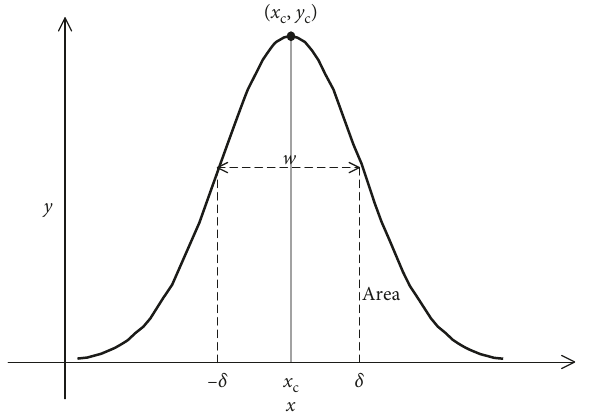
Figure 2: A Gaussian fitting curve of equation (8). Table 1: Details on EC stations used for validity verification.